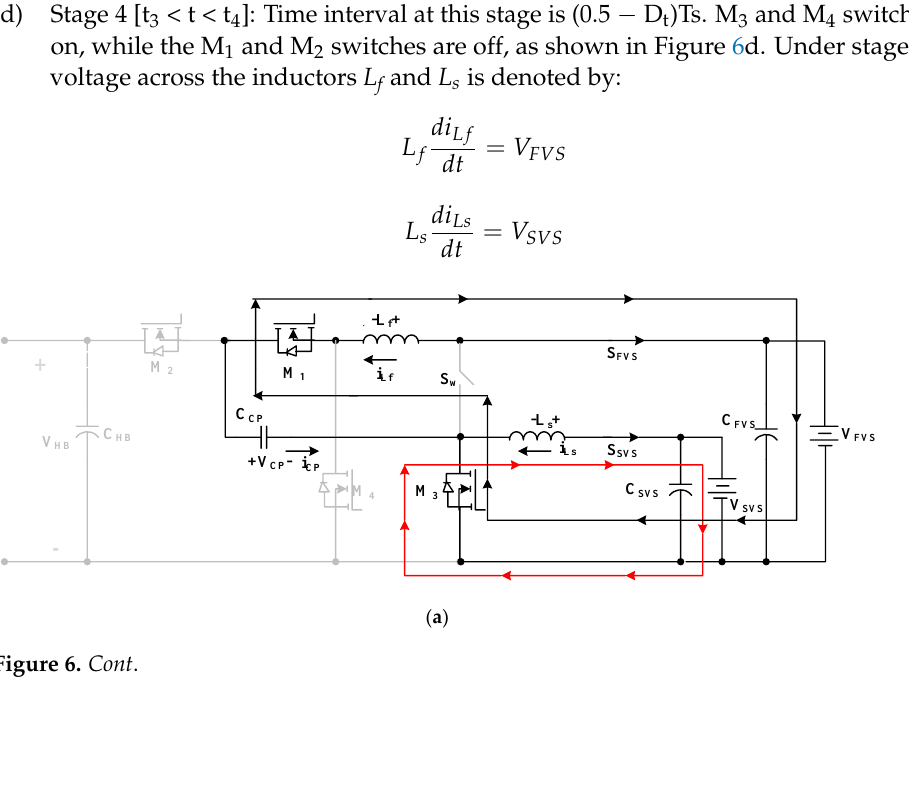
Figure 5. ( a ) Schematic Diagram. ( b ) Waveforms of BDC ’ s DC-bus high voltage energy-regenerative mode. The duty ratio of the energy-regenerating mode for DC-bus high-voltage steady-state waveforms is less than 50%. Their four circuit stages are illustrated through Figure 6a – d.